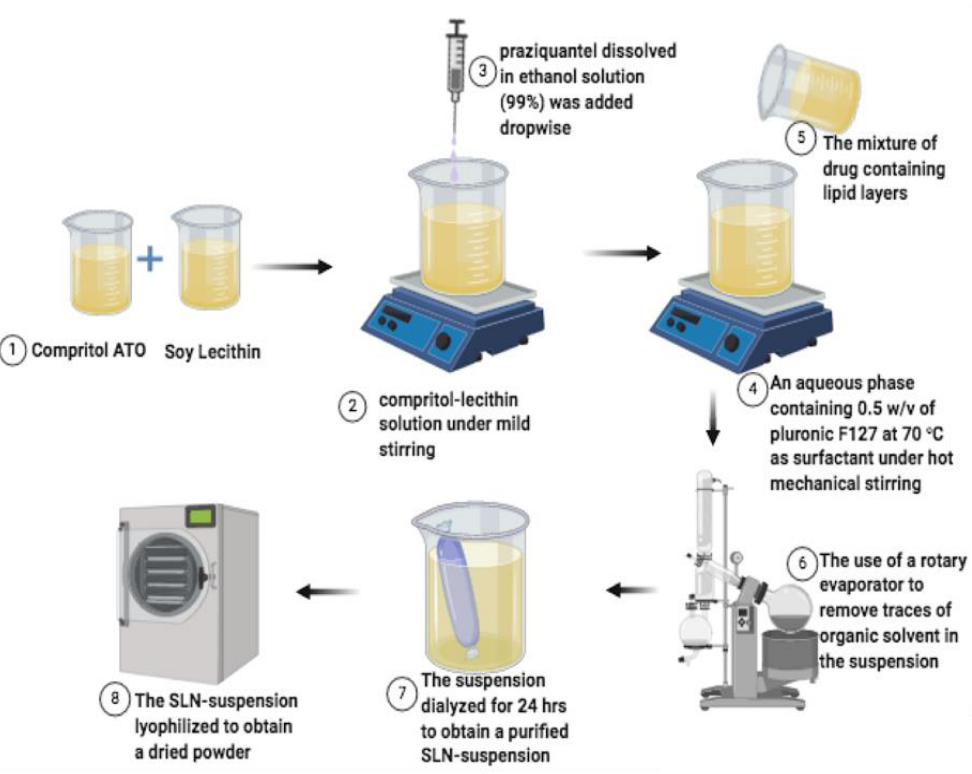
Figure 17. The schematic overview showing the preparation procedure for praziquantel-loaded Compritol-lecithin SLNs.